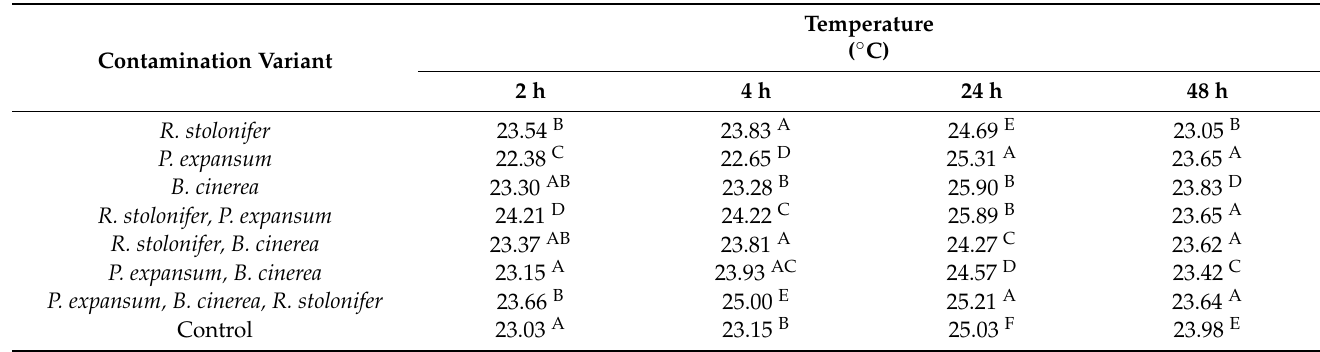
Table 1. Comparison of temperature changes in samples in subsequent hours of incubation according to the contamination